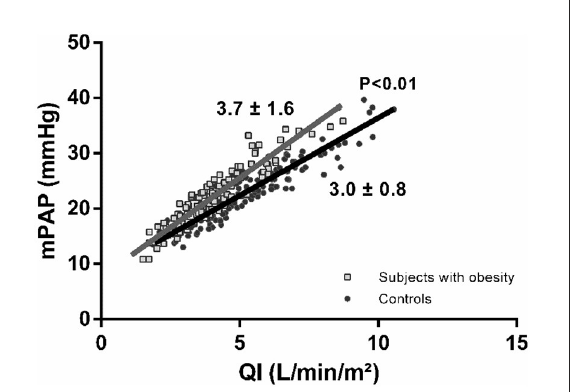
FIGURE2 Poon-adjusted mean pulmonary artery pressure (mPAP)-cardiac index (QI) relationships in subjects with obesity (gray squares) vs. controls (black circles). Subjects with obesity present increased mPAP-QI